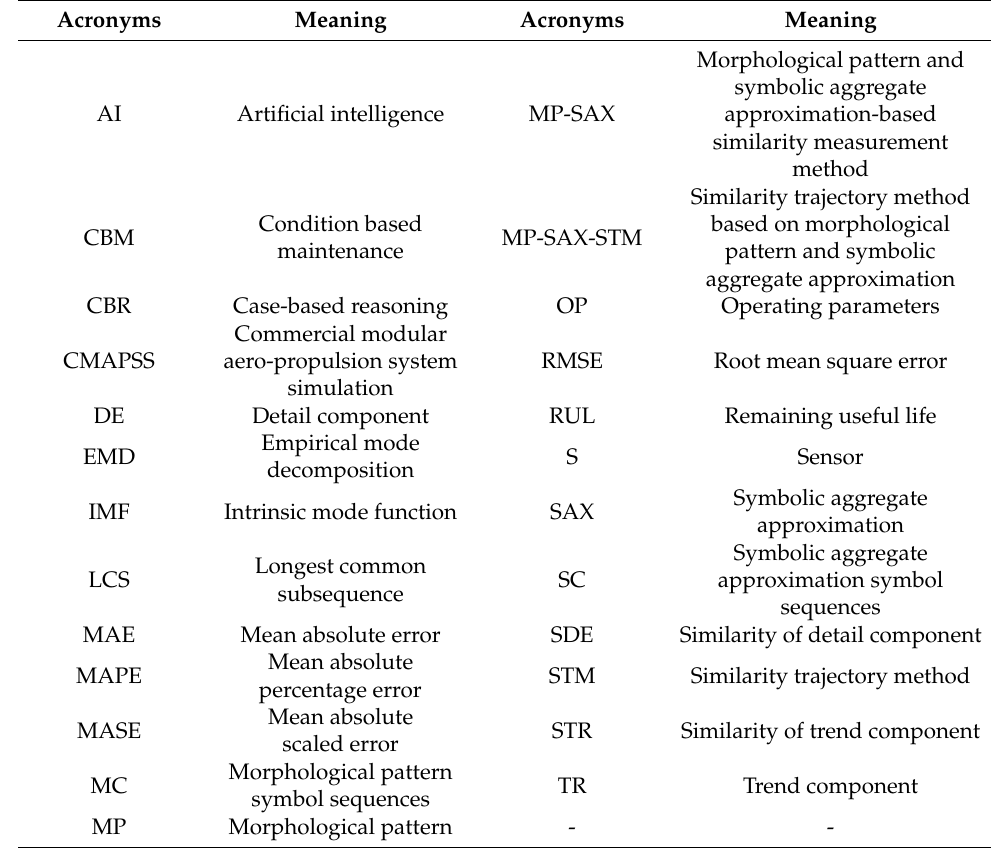
Table A1. Meaning of